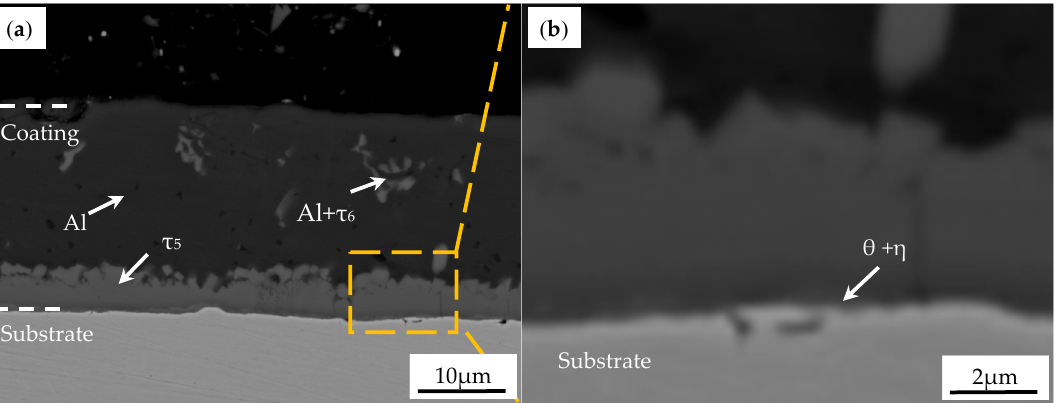
Figure 1. Electron probe microanalyzer (EPMA) micrographs of the interface between the AS60/60 coating and the steel substrate in the hot-dipped condition: ( a ) AS60/60 coating; ( b ) micrograph of the area marked by the yellow rectangle in ( a ) at higher magnification.